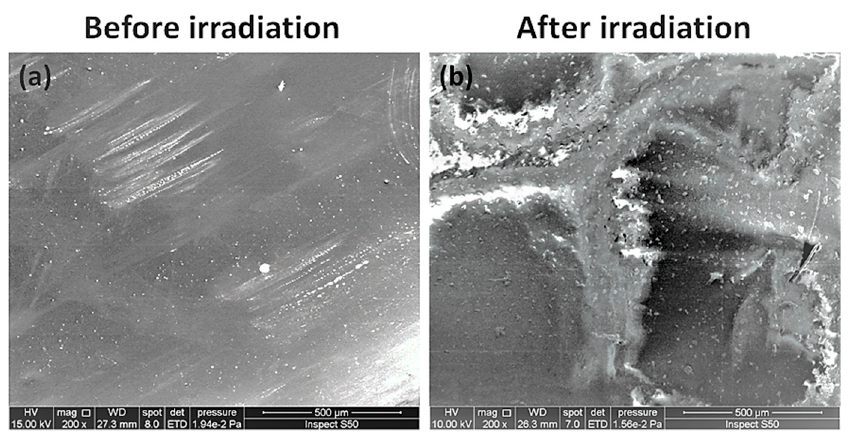
Figure 13. SEM images of the blank PVC film ( a ) before and ( b ) after irradiation.